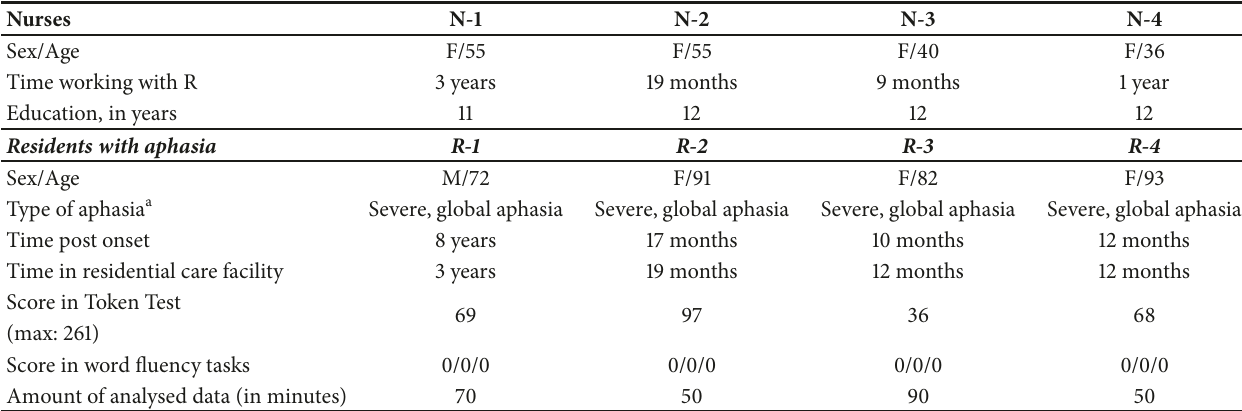
Table 1: Description of nurses (N) and the residents with aphasia (R) including measures of comprehension in Token test [48] and verbal fluency [49] and amount of data from each